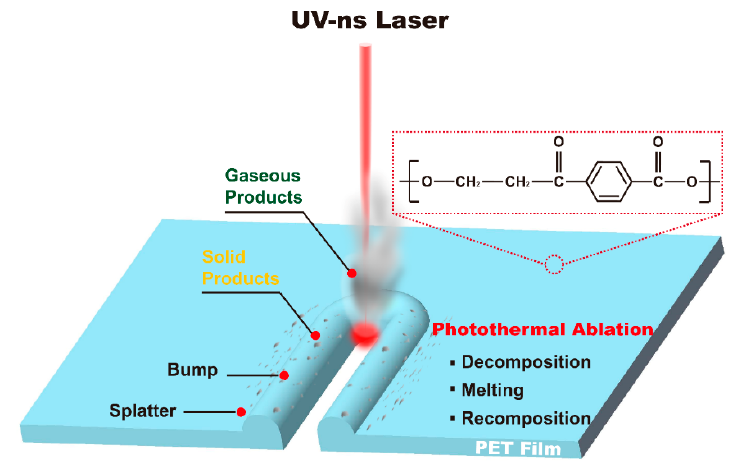
Figure 7. Schematic diagram of the interaction mechanism between the UV-ns laser and the PET